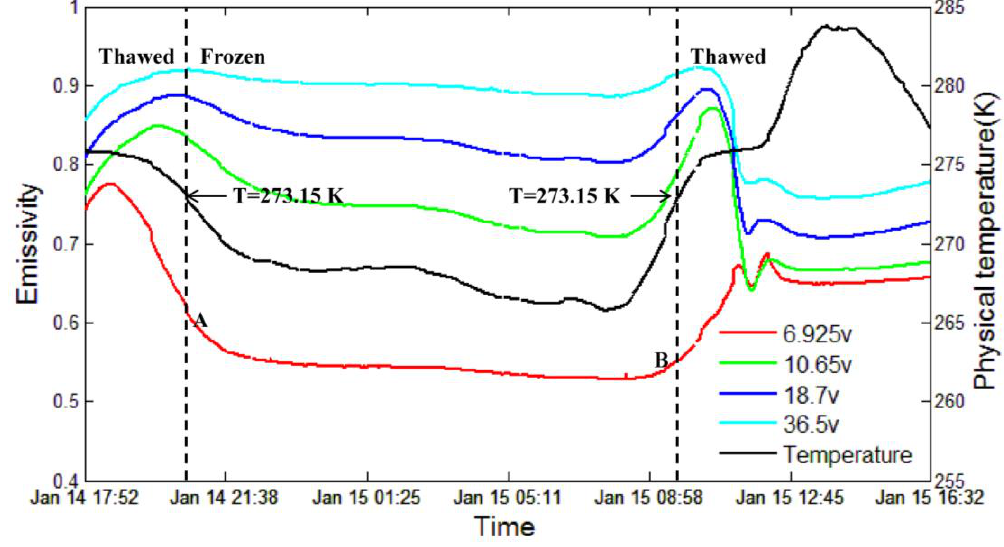
Figure 8. Emissivity and physical temperature variations measured in 0.63 cm-thick soil.